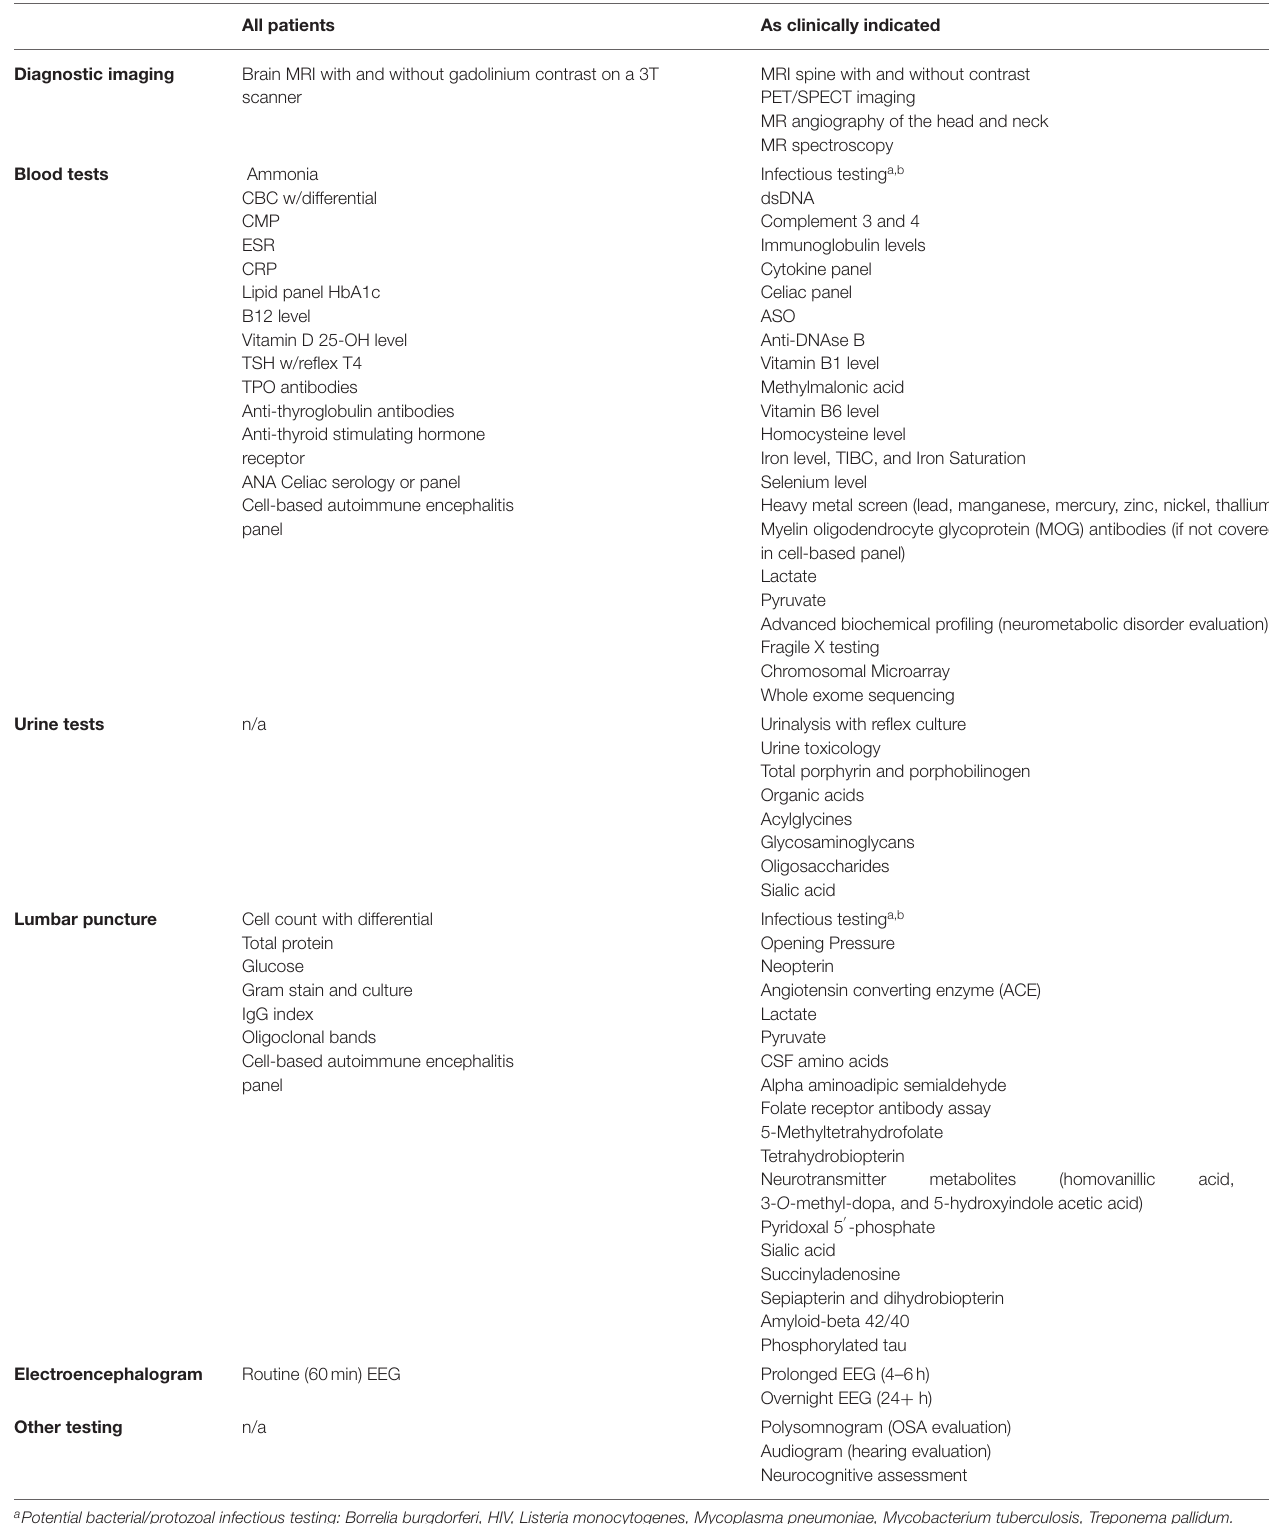
measles, rabies, varicella zoster, west Nile virus and other region-dependent viral testing.